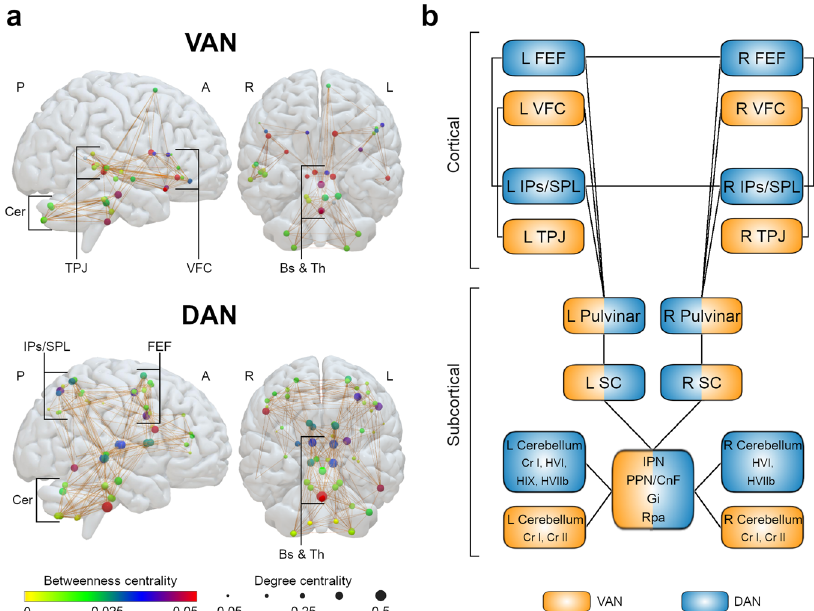
Fig. 5 Graph theory analysis and anatomical model of the VAN and DAN. a Graph theory analysis of the VAN and DAN structural connectivity. Circles illustrate nodes. Circle colors represent the median betweenness centrality of each node (according to the color gradient), while circle dimensions represent the median degree centrality. Brown lines represent node-to-node structural connections present in at least half of the subjects. b Anatomical model of the VAN and DAN. A anterior, CnF cuneiform nucleus, DAN dorsal attention network, Gi gigantocellular nucleus, IPN interpeduncular nucleus, L left, P posterior, PPN pedunculopontine nucleus, Pul pulvinar, R right, Rpa raphe pallidus nucleus, SC superior colliculus, VAN ventral attention